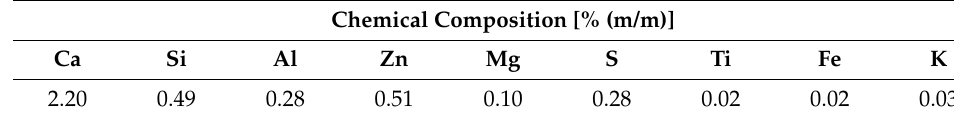
Figure 1. Production waste from the production process of car floor mats: ( a ) initially crushed material; ( b ) material crushed to 2–8 mm fraction. Table 1. Percentage content of the elements in the production waste.